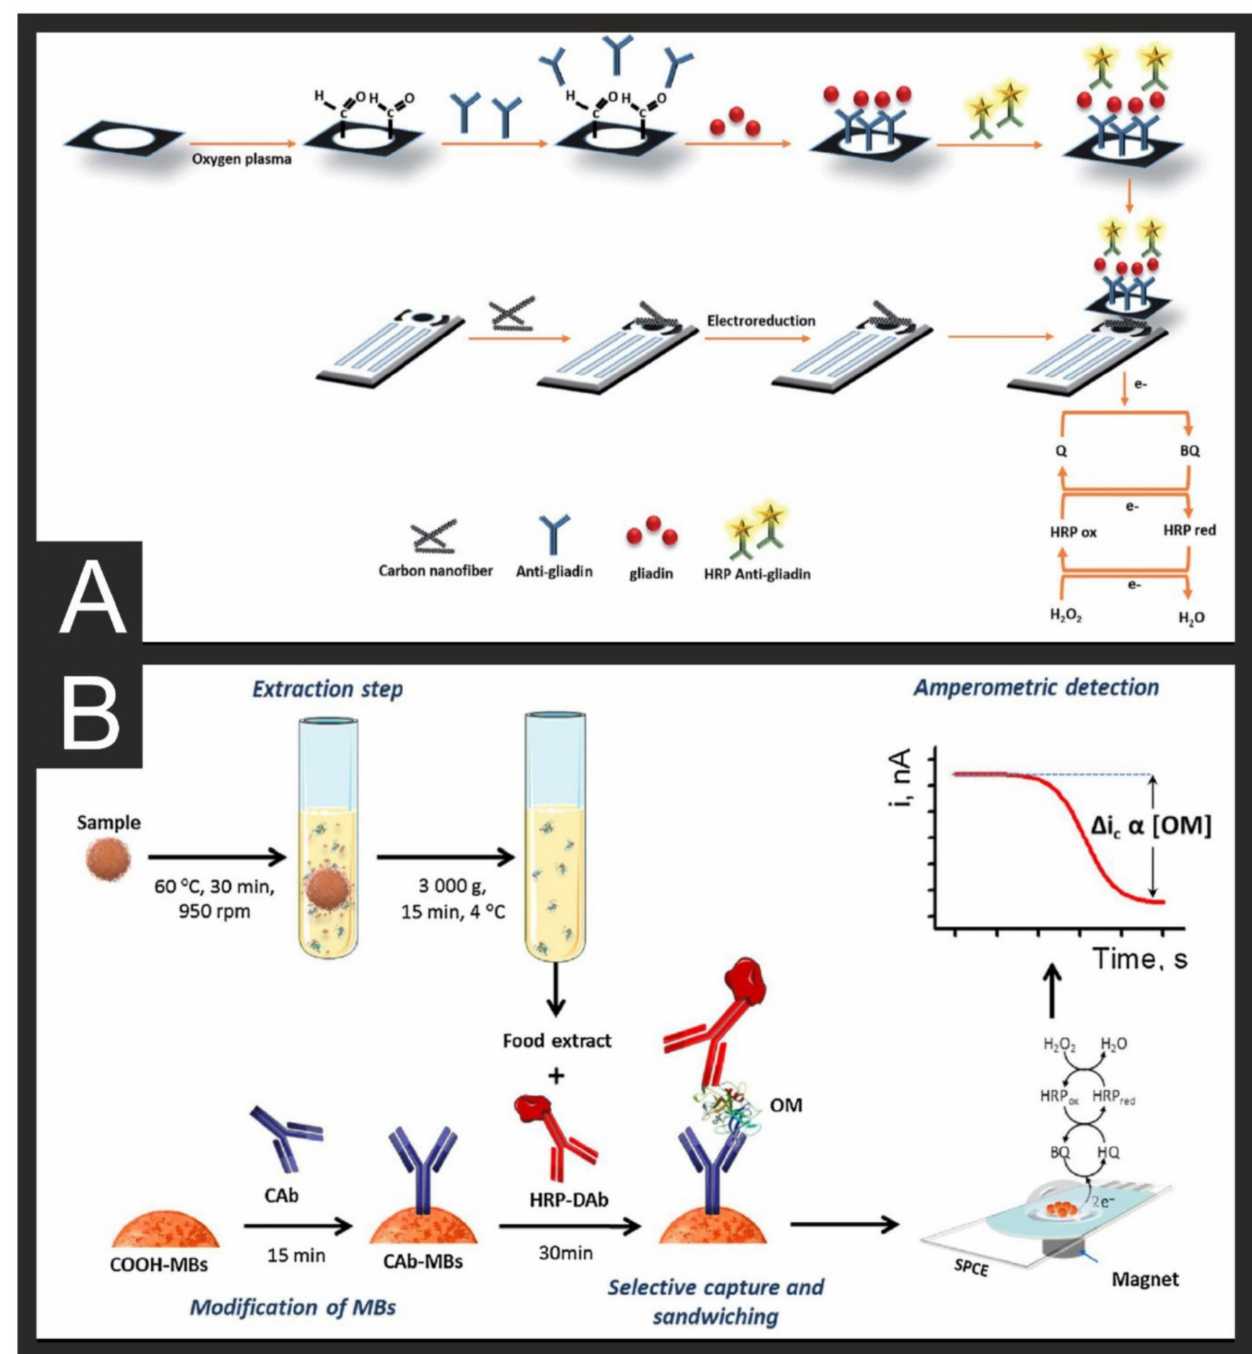
Figure 5. ( A ) Schematic representation of the electrode modification and gliadin determination procedures. Reproduced with permission from [50]. Copyright Royal Society of Chemistry 2019. ( B ) Schematic display of the fundamentals involved in the immunosensing platform developed for OM determination. Reproduced with permission from [51]. Copyright Elsevier